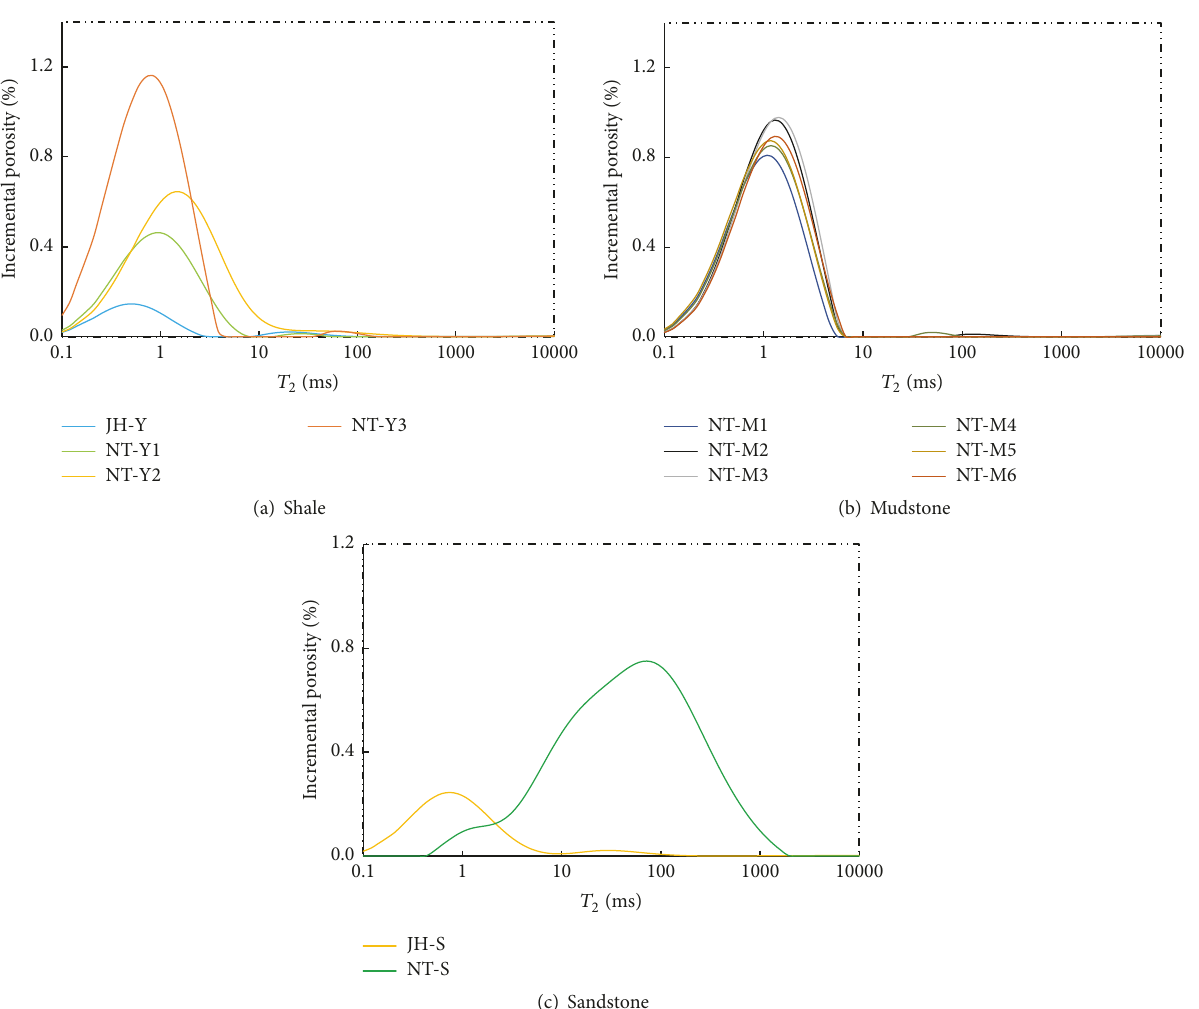
Figure 8: 𝑇 2 spectra of the NMR measurements under the full water-saturated ( 𝑆 𝑤 ) condition for the investigated samples.